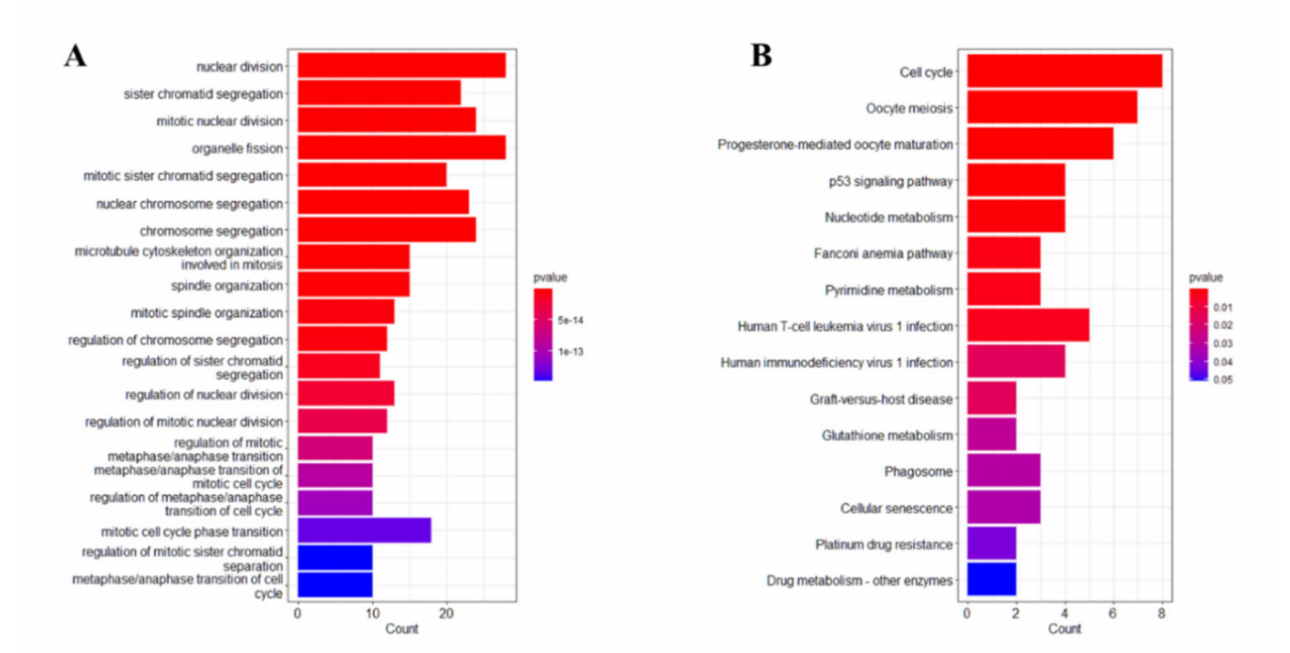
Figure 5. GO and KEGG enrichment analysis. ( A ): GO functional enrichment analysis; ( B ): KEGG functional enrichment analysis.